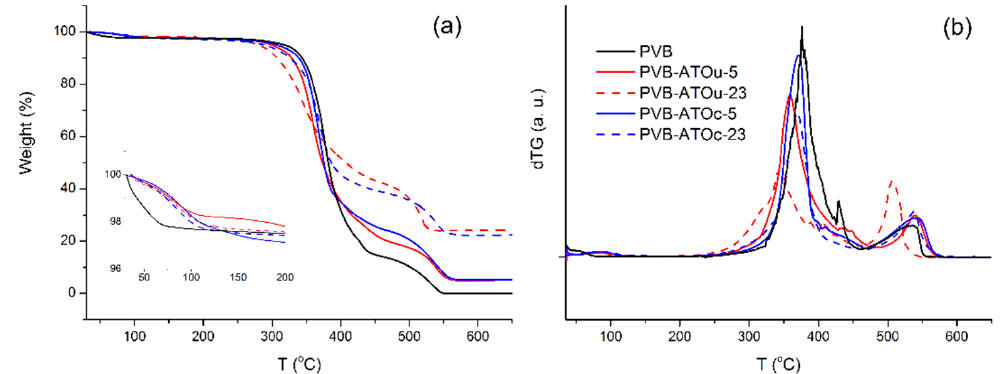
Figure 6. TGA thermograms of PVB (black line), PVB-ATOu-5 (red solid line), PVB-ATOu-23 (red dashed line), PVB-ATOc-5 (blue solid line) and PVB-ATOc-23 (blue dashed line). The remaining weight percentage with respect to the initial value and the dTG profiles are represented in panel ( a ) and ( b ), respectively. The inset in ( a ) shows the weight loss due to water desorption between 30 and 200 ◦ C. Table 1. ATO nanoparticles (NPs) weight and volume percentages, characteristic degradation temperature T max for the main degradation process and calorimetric T g values of neat PVB and PVB-ATO composites. Sample ATO wt % ATO vol % T max ( ◦ C) T g ( ◦ C)